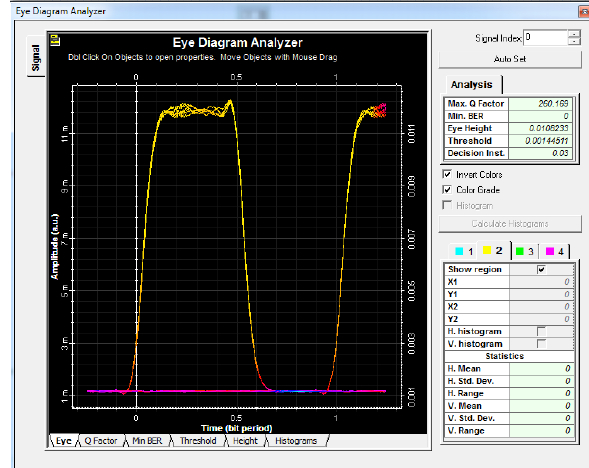
Figure 3: Results of the eye diagram analyzer with the directly modulated laser source along a cable length of 10 km.